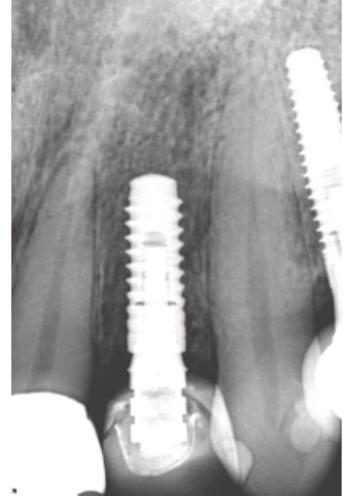
Figure 13: One year following implant